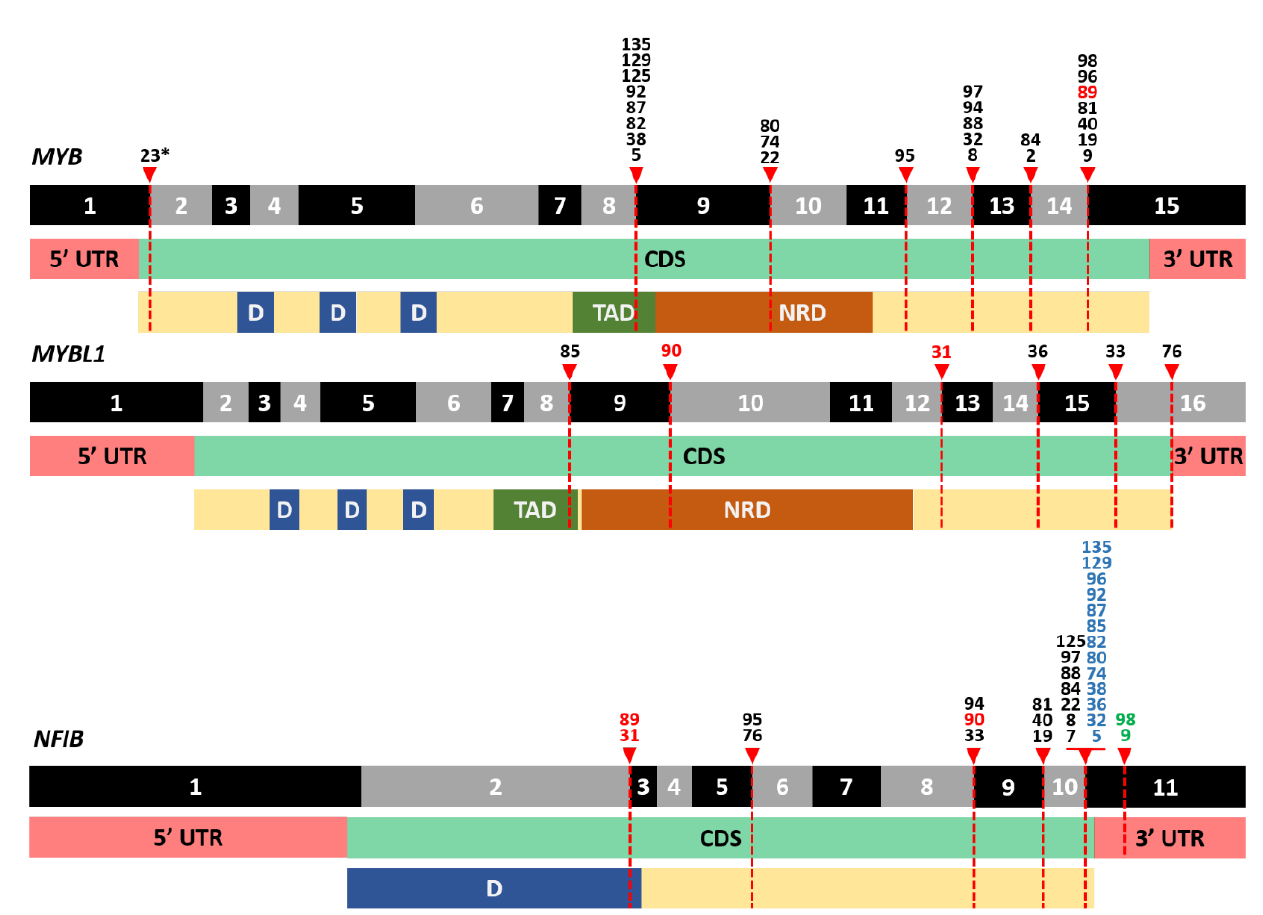
Figure 3. Overview of identified breakpoints in the MYB , MYBL1 and NFIB genes and their location in functional domains of the proteins encoded by these genes. Numbers indicate unique cases. Used